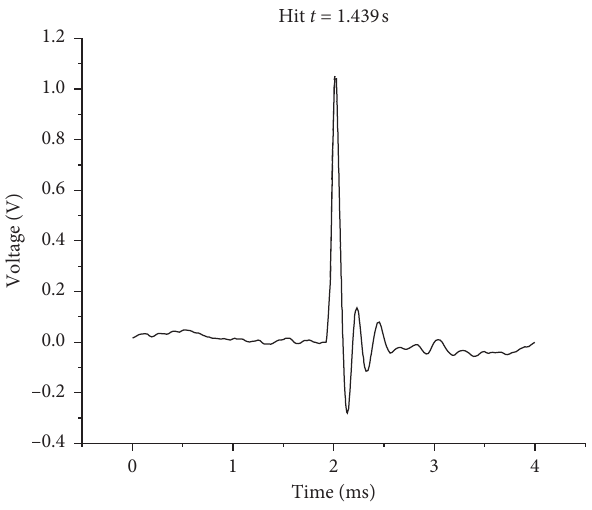
Figure 4: Single hit of barley.